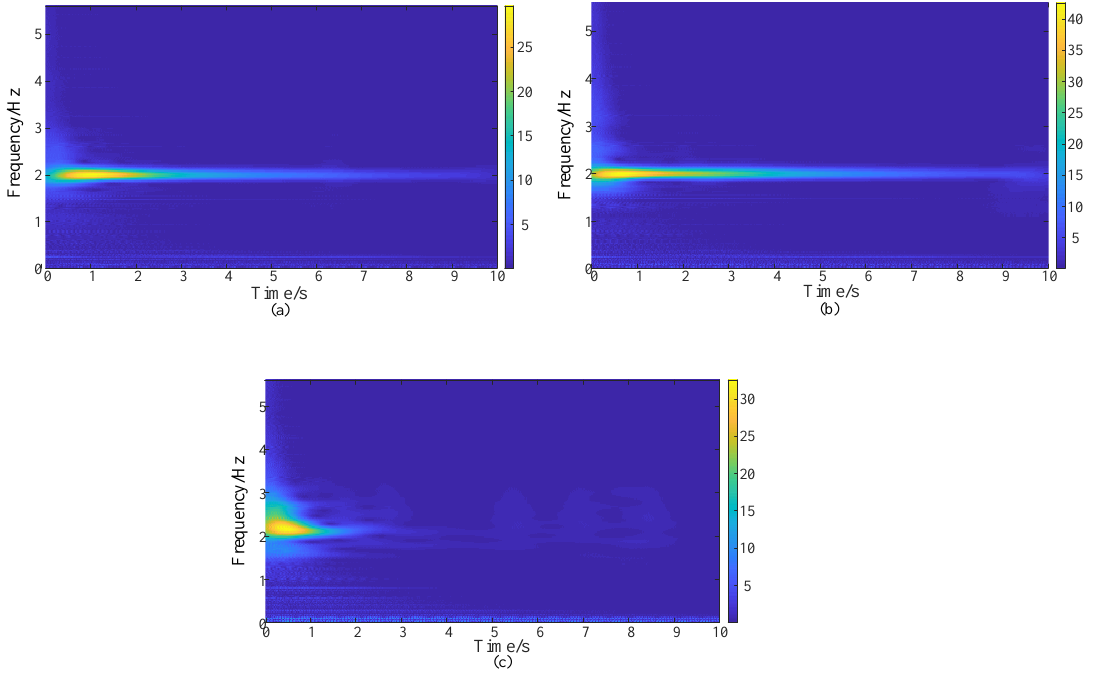
Figure 16. Time-frequency analysis of the extracted signal. ( a ) Excitation at dropper 10, with an uplifted